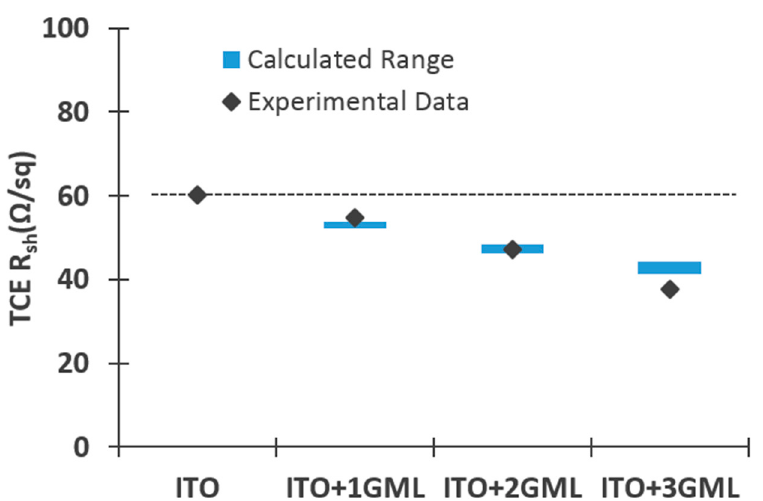
Figure 5. Measured sheet resistance (scatter plot) using THz-TDS and the calculated range of values (blue colored areas) according to Equation (2), considering a sheet resistance for the graphene monolayers of 450 ± 50 Ω /sq. The dotted line is a guide to the line positioned at a value equal to the measured ITO sheet resistance.